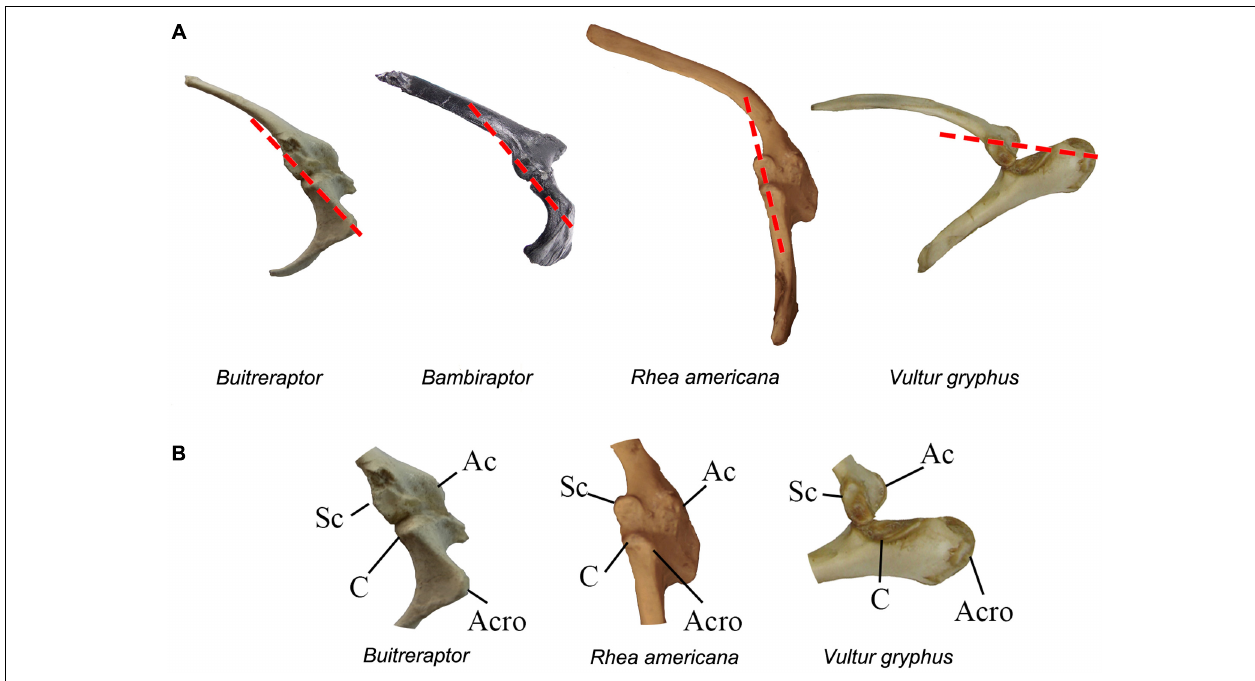
FIGURE 12 | (A) Lateral view of the right scapulocoracoid in selected basal and derived paravians. The dotted lines indicate the inclination of the major axis of the glenoid cavity. (B) Detail of the glenoid of the right scapulocoracoid of selected paravians in lateral view. Not to scale. C, coracoidal portion of the glenoid; Sc, scapular portion of the glenoid, Ac, acromion; Acro, acrocoracoid or biceps